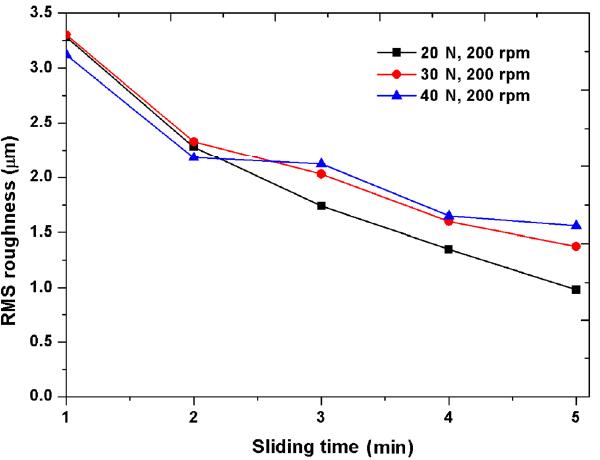
Fig. 15 Variation of S q with sliding time for the same speed and different loads.